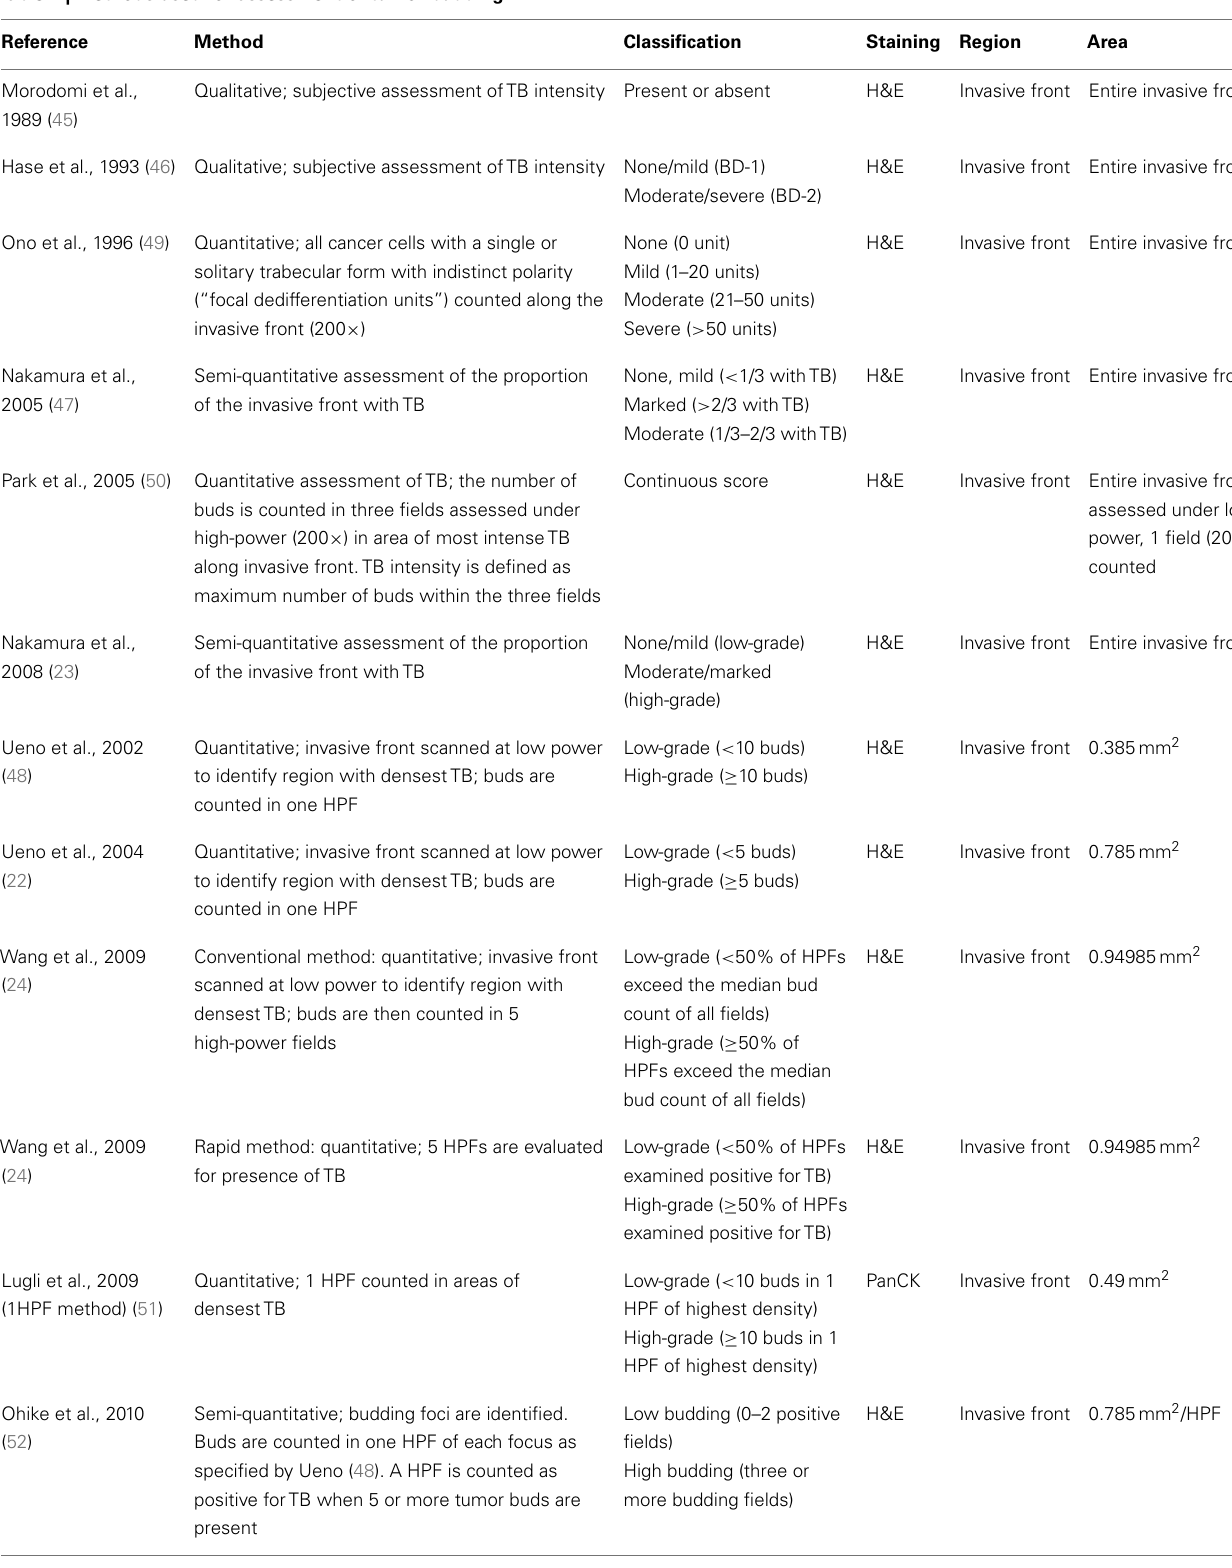
Table 1 | Methods used for assessment of tumor budding